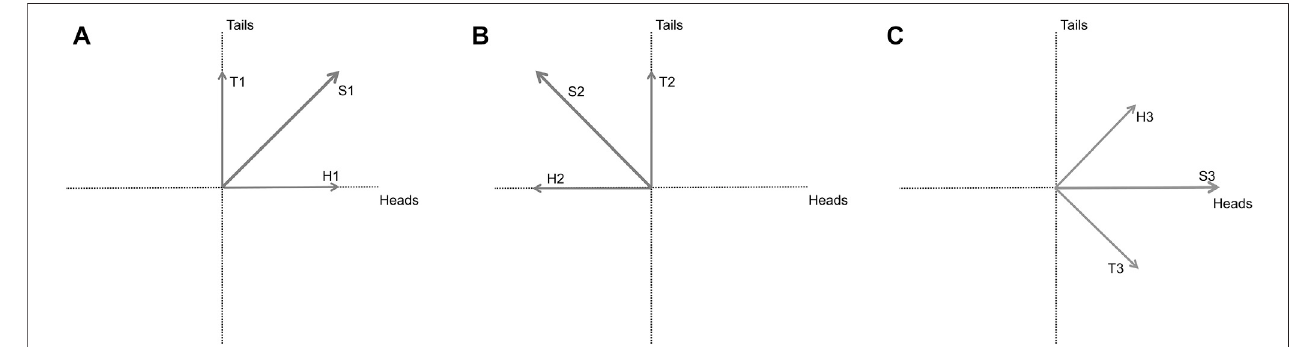
FIGURE 1 | (A) A coin toss for a balanced coin can be expressed as a superposition of two states, heads and tails. (B) because the 2-norm of a probability is its square, we can also consider negative projections. (C) Applying the Hadamard transformation rotates S1 by 45 degrees clockwise which aligns with the H axis